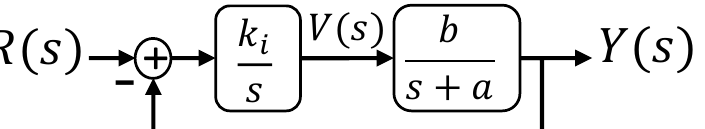
Figure 4. Reference tracking problem with integral control of a stable first-order